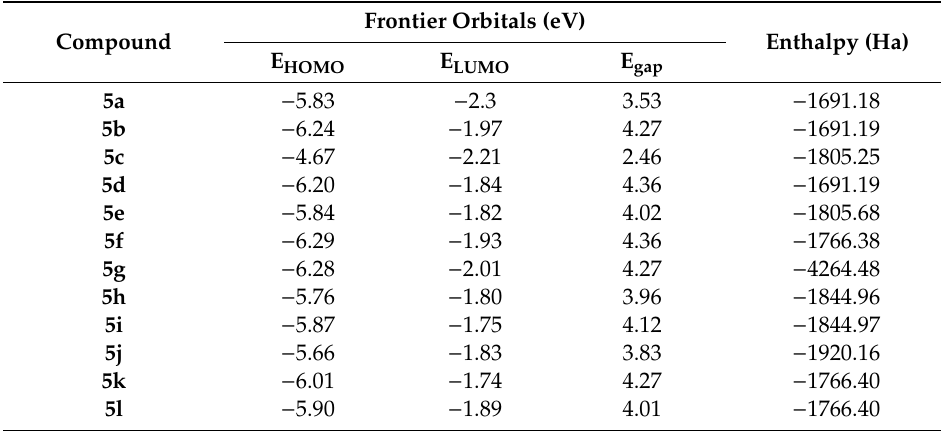
Table 5. The energies of the frontier orbitals HOMO, LUMO, and the enthalpy of the radicals derived from compounds 5a – l . Frontier Orbitals Radical of Position of the Compound Radical